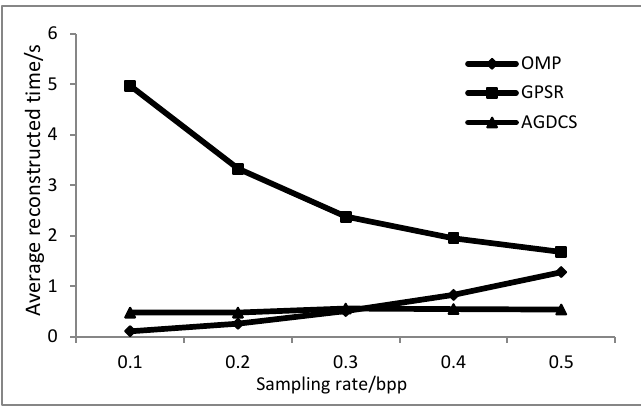
Figure 13. Comparison of the average reconstructed time of all bands for different algorithms.